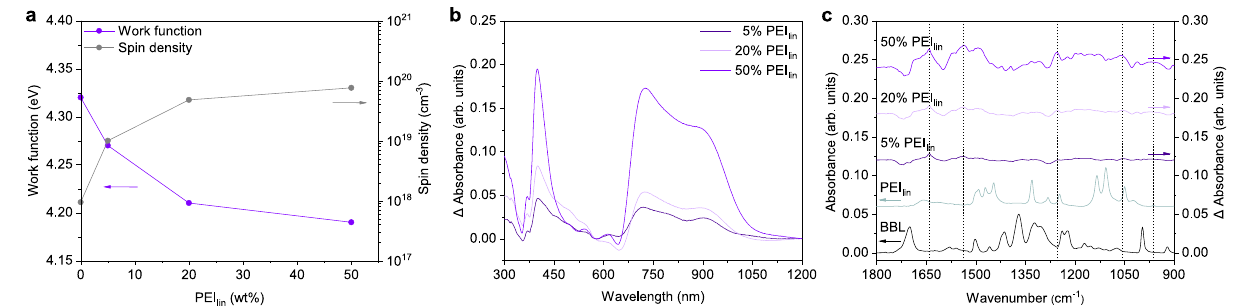
Fig. 4 Spectroscopic con fi rmation of doping. a Evolution of the work function measured by UPS and the spin density measured by EPR for BBL:PEI lin fi lms with different PEI content. b Difference UV-Vis absorption spectra of BBL:PEI lin (50 wt%) showing the evolution of polaron absorption induced by the increased PEI content. c The corresponding difference FTIR absorption spectra of the same samples. The difference absorption spectra in b and c were obtained by subtracting the BBL spectrum from the BBL:PEI lin spectra after normalization at 575 nm and 1370 cm − 1 for UV-Vis and FTIR, respectively. A similar analysis is reported in Supplementary Fig. 26 for BBL:PEI